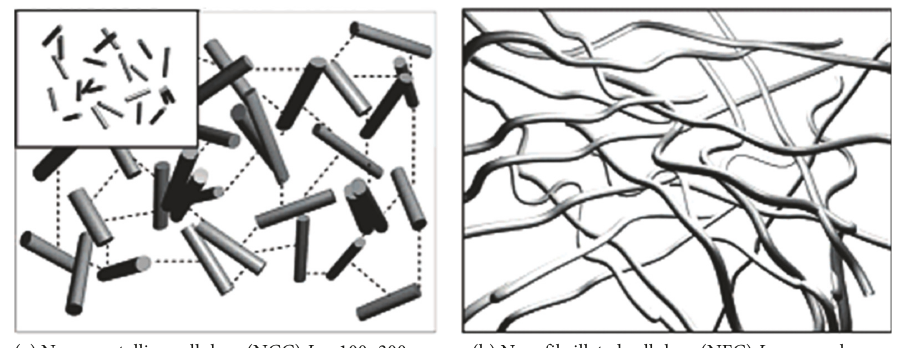
Figure 1: Diagram of NCC and